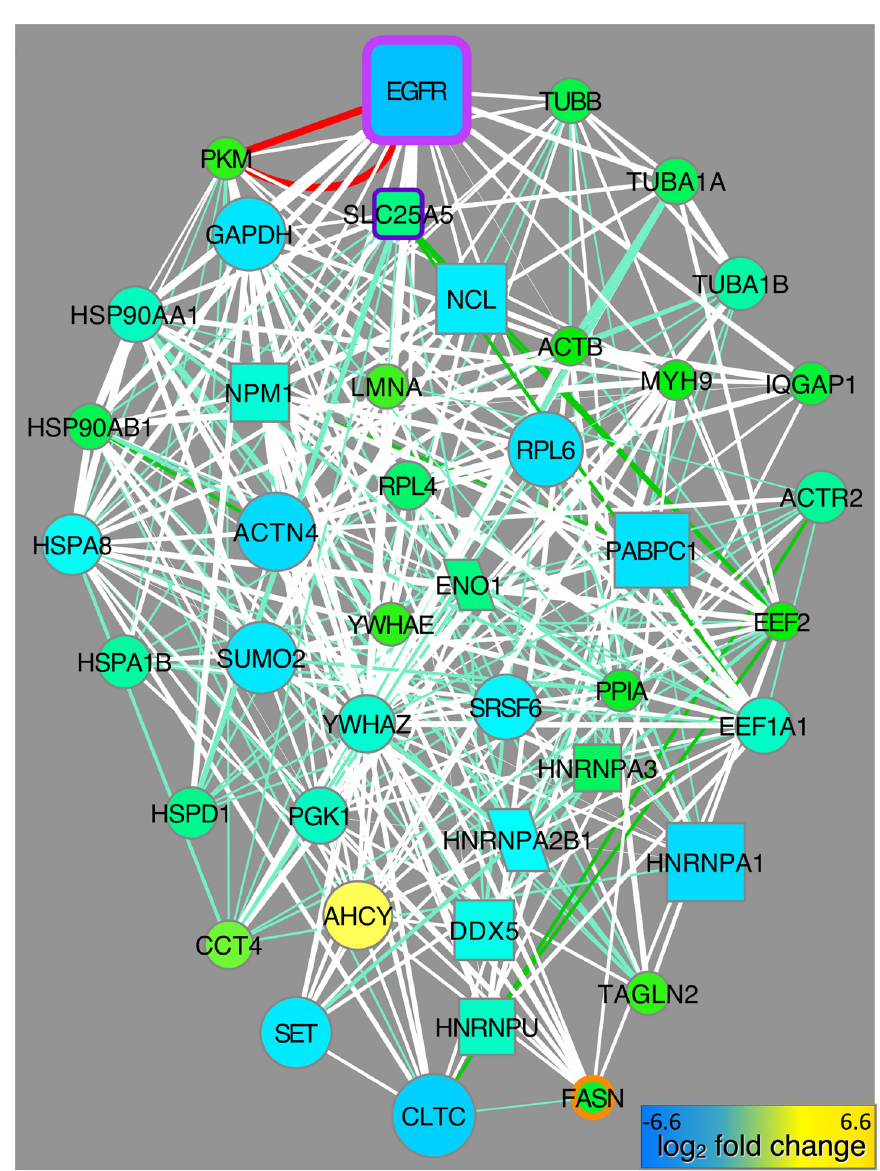
Fig 7. Common core CFNs from different lung cancer PTM data sets. The 43 proteins (excluding the ribosomal protein clique) that were in the highest cores of both CFNs graphed with CFN edges from this study. Node size and color indicates PTM changes in PC9 cells treated with erlotinib. Node border and shape and edge colors are defined in S2C